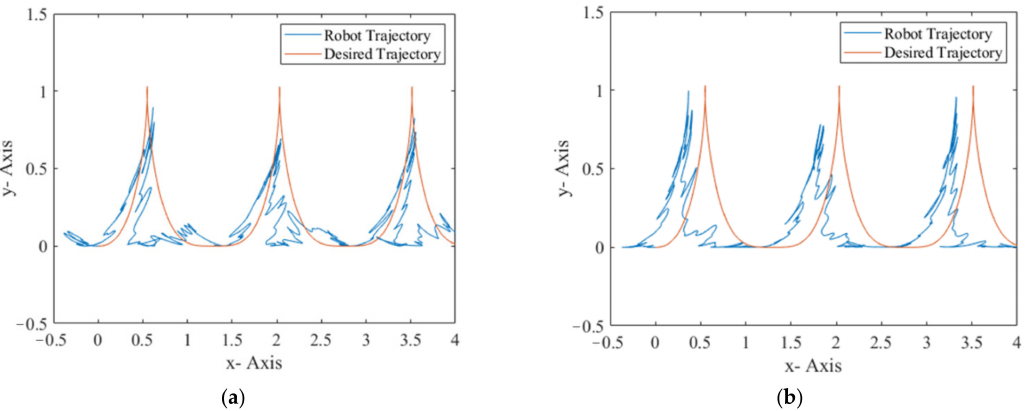
Figure 11. Comparison of ( a ) best simulation with the IT3FC and ( b ) worst simulation with the IT3FC proposed methods with BLW noise.